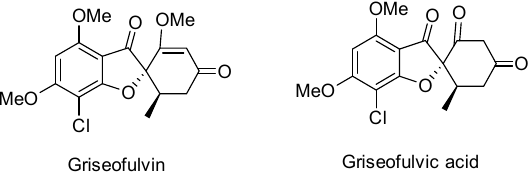
Figure 1. The structures of Griseofulvin and Griseofulvic acid.